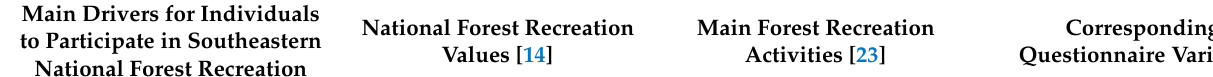
Table 3. Relationships between main drivers for individuals to participate in Southeastern National Forest Recreation, main values of National Forest Recreation, and questionnaire